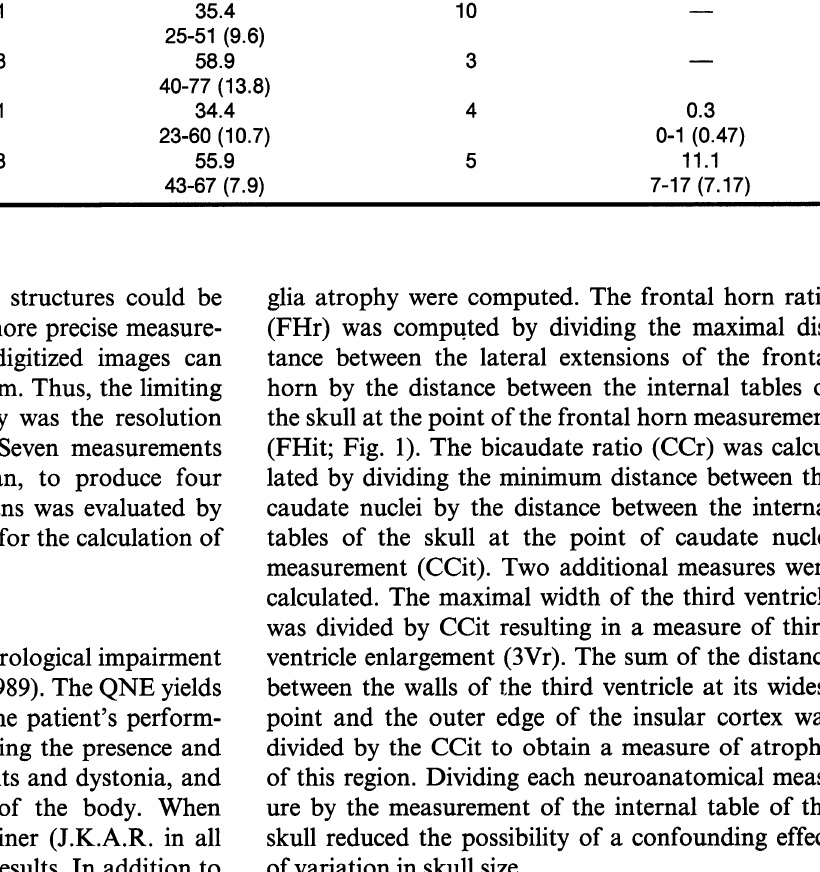
TABLE I. Age, sex and disease duration of patient groups Group n Mean age and Number Mean disease duration "Early" control 11 35.4 10 "Late" control 8 58.9 3 "Early"